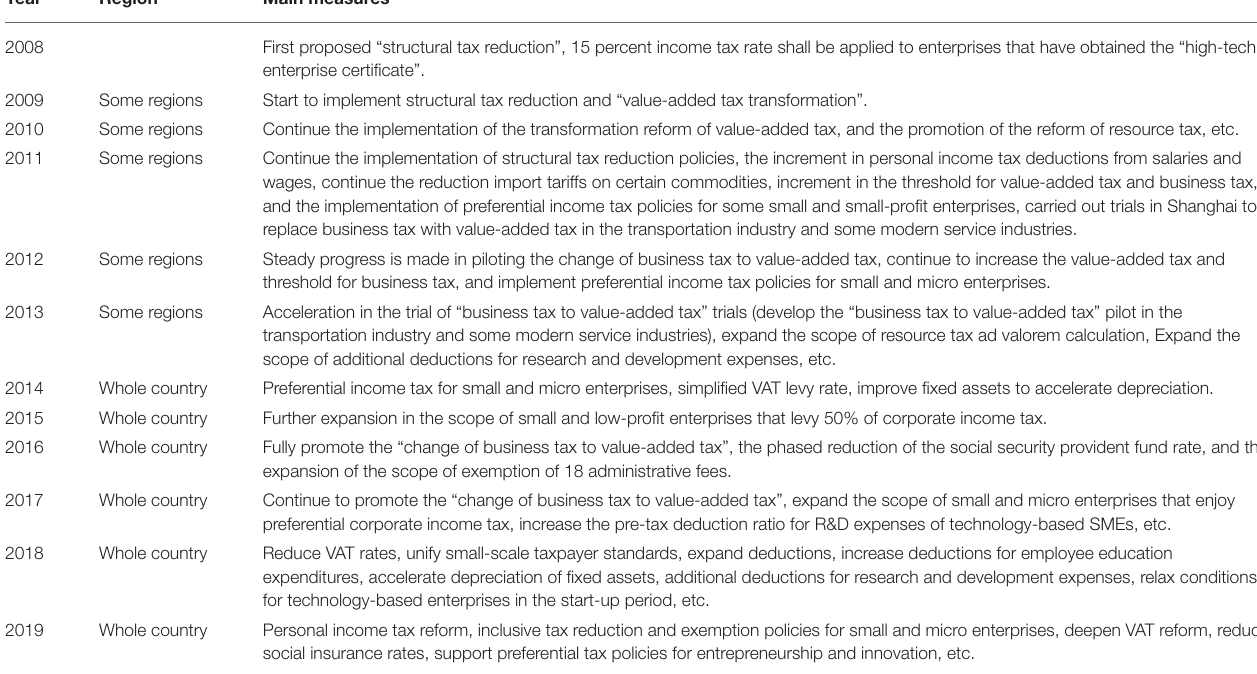
TABLE 1 | Major tax reduction in recent years.